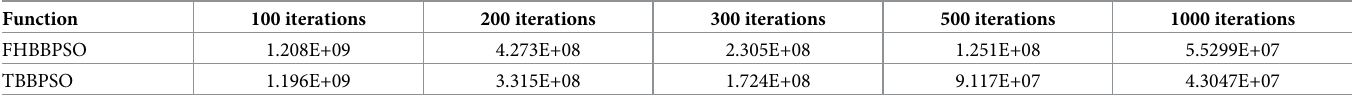
Table 2. MEs of TBBPSO and